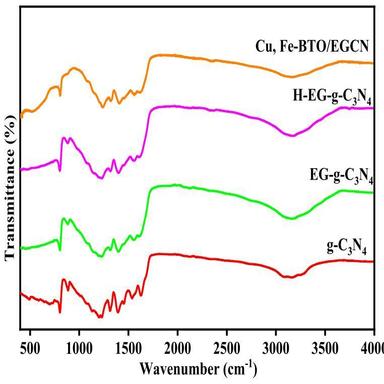
FTIR analysis of g-C3N4, EG-g-C3N4, H-EG-g-C3N4 and Cu, Fe-BTO/EGCN.